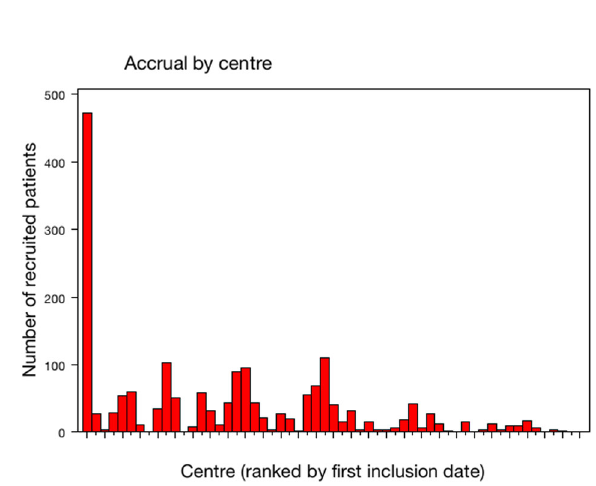
Fig. 3 Patient ’ s number for each